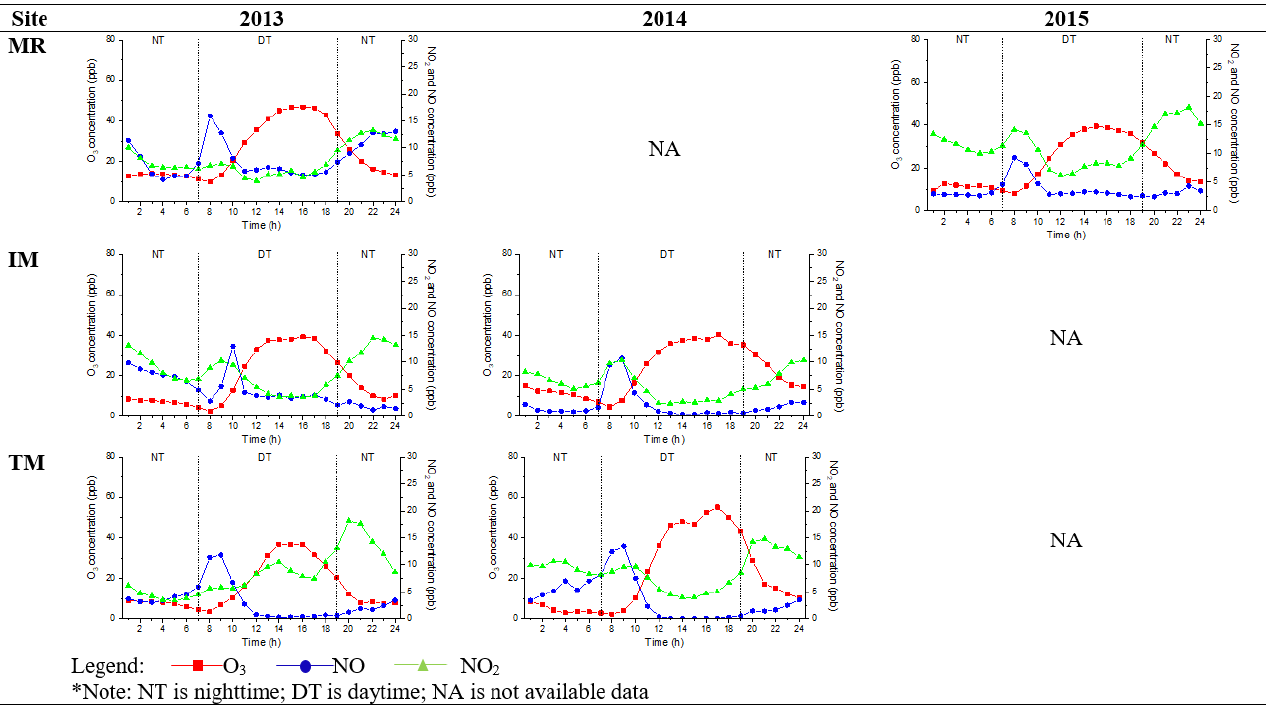
Figure 4. Hourly diurnal plot of O 3 , NO 2, and NO, at suburban sites (MR, IM, and TM) in 2013, 2014, and 2015. and